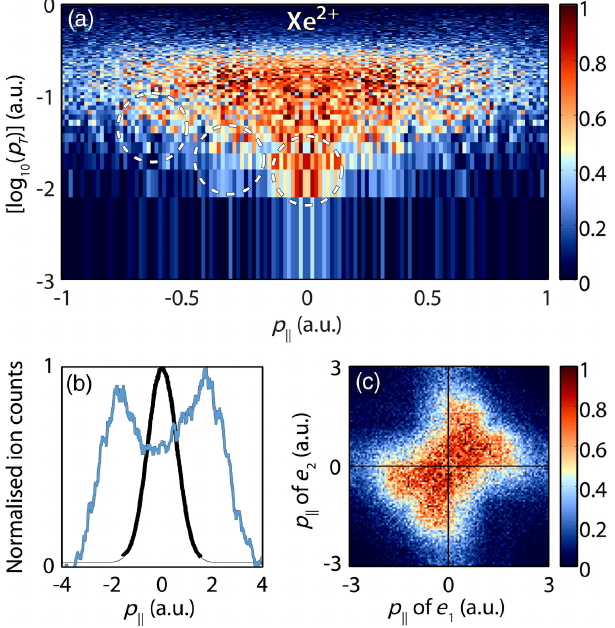
FIG. 10. (a) The electron momentum distribution correspond- ing to Xe 2 þ ions for the same experimental conditions as in Fig. 9. (b) The longitudinal momentum distribution of the Xe 2 þ ions (blue curve) where a dip at p ∥ ¼ 0 indicates the involvement of electron recollision. For reference, the single peak distribution of the Xe þ ions is also presented (black curve) along with a Gaussian fit (gray curve). (c) The correlated two-electron momentum distribution, which features a crosslike shape with a preference to the first and third